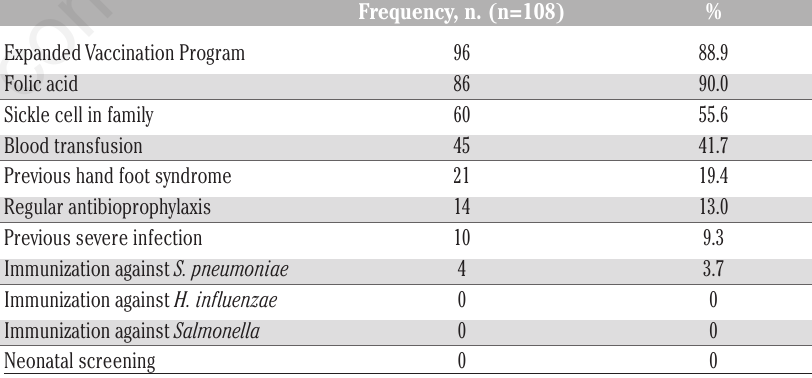
Table 1. Distribution of medical history of 108 children at admission.